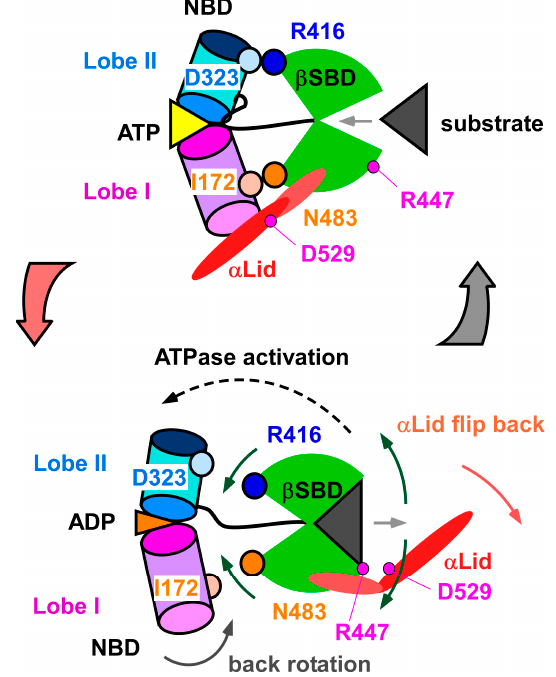
Figure 8. Schematic showing interdomain communication with structural changes to both the SBD and NBD in association with client-peptide binding, and ATP hydrolysis and ADP turn over. The client-peptide (substrate) binding to SBD causes rearrangement of residues at the interdomain contact site to impair the interaction between SBD and NBD, which induces the back rotation of Lobe I in interaction that connects the α Lid to the β SBD and is mediated by a salt bridge between R447 and